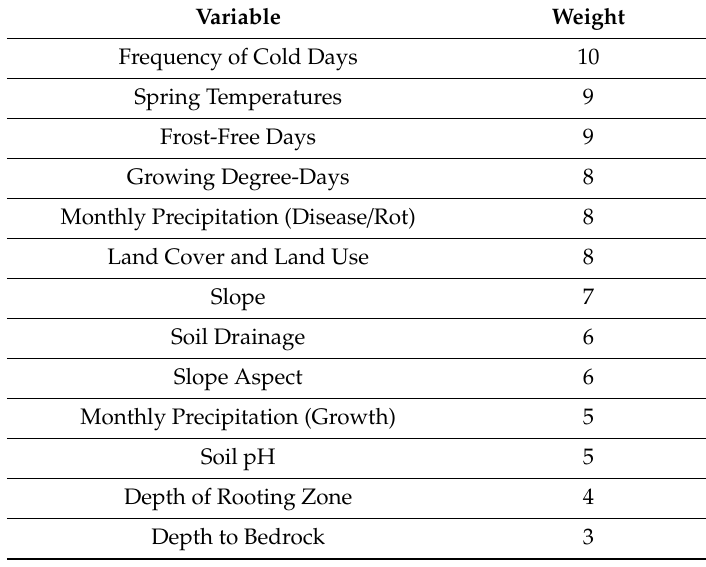
Table A1. Final variable weights used in the LSE models for vinifera production in